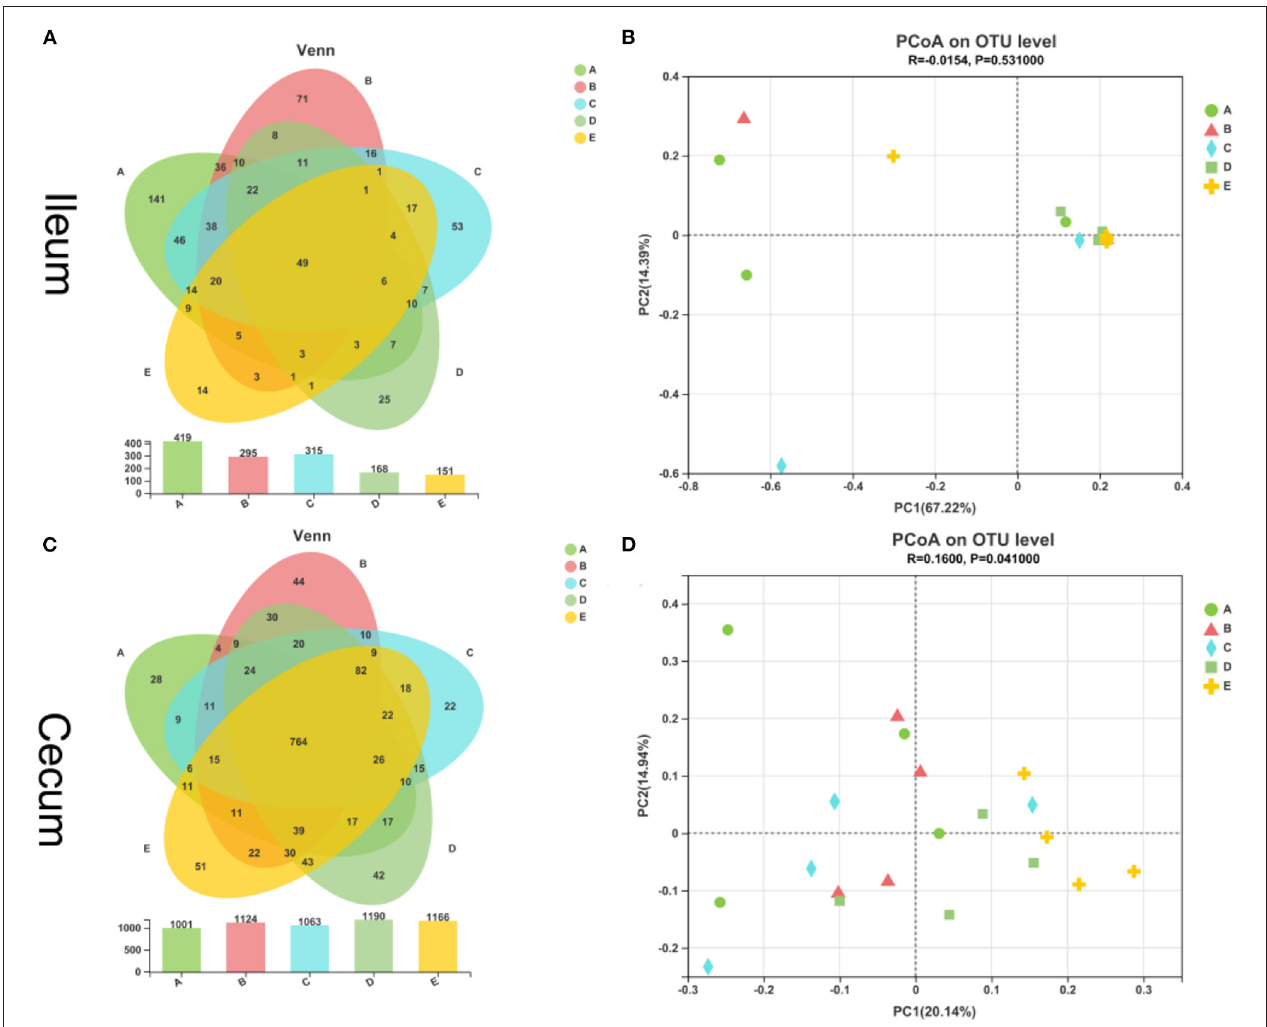
FIGURE 1 | Similarity of intestinal bacterial community of weaned piglets. (A) Venn of the OTUs in the ileum by different treatments. (B) Principal coordinates analysis (PCoA) of ileal digestal bacterial community. (C) Venn of the OTUs in the cecum by different treatments. (D) Principal coordinates analysis (PCoA) of cecal digestal bacterial